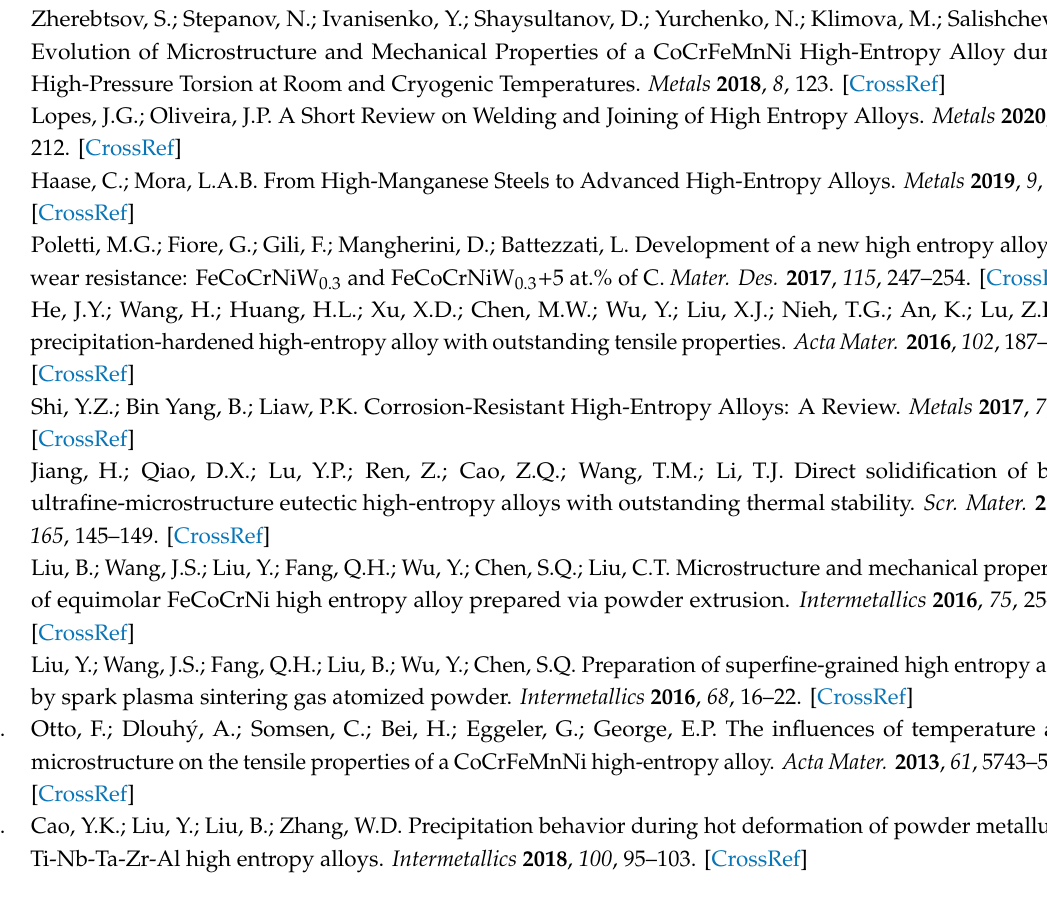
Figure S1: SEM images of the HEA for calculating the mean size and volume fraction of carbides by using Image Pro Plus, Figure S2: Hardness of the HEA after heat treatment at di ff erent temperatures for 4